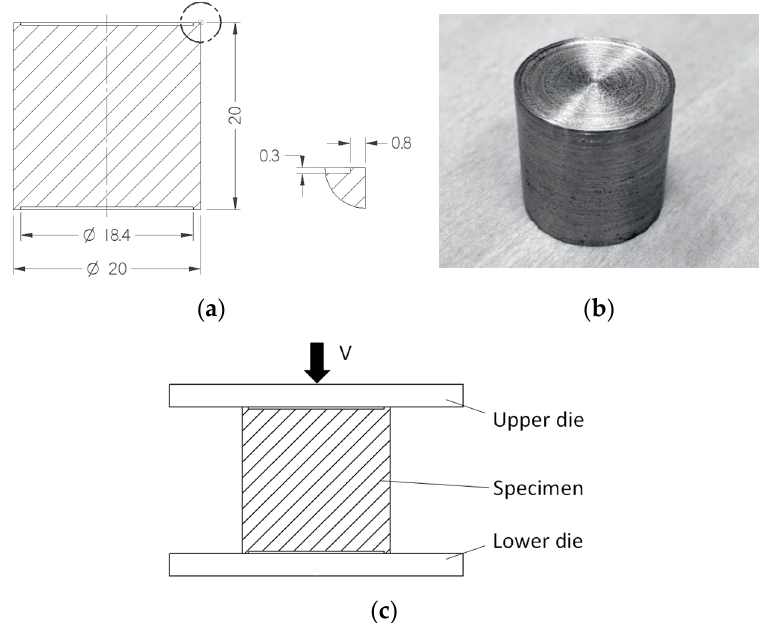
Figure 2. Schematic diagram of the specimens ( a ), a specimen image ( b ), and a schematic diagram of the process ( c ).